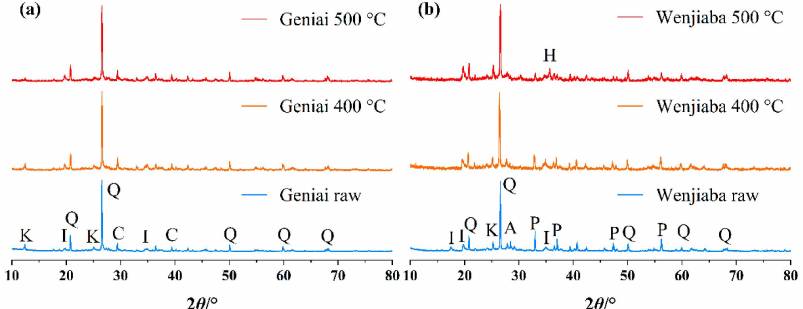
Figure 2. XRD spectra of ( a ) the Geniai shale and ( b ) the Wenjiaba shale. A: Albite; C: Calcite; H: Pyrrhotite; I: Illite; K: Kaolinite; P: Pyrite; Q: